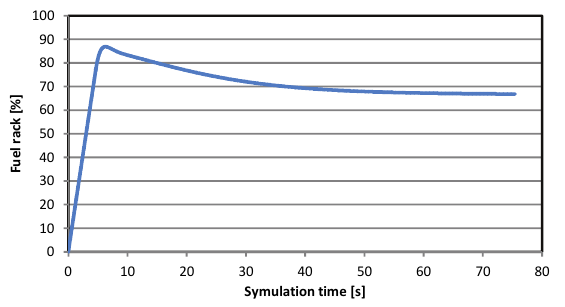
Fig. 7. Position of fuel rack during simulation